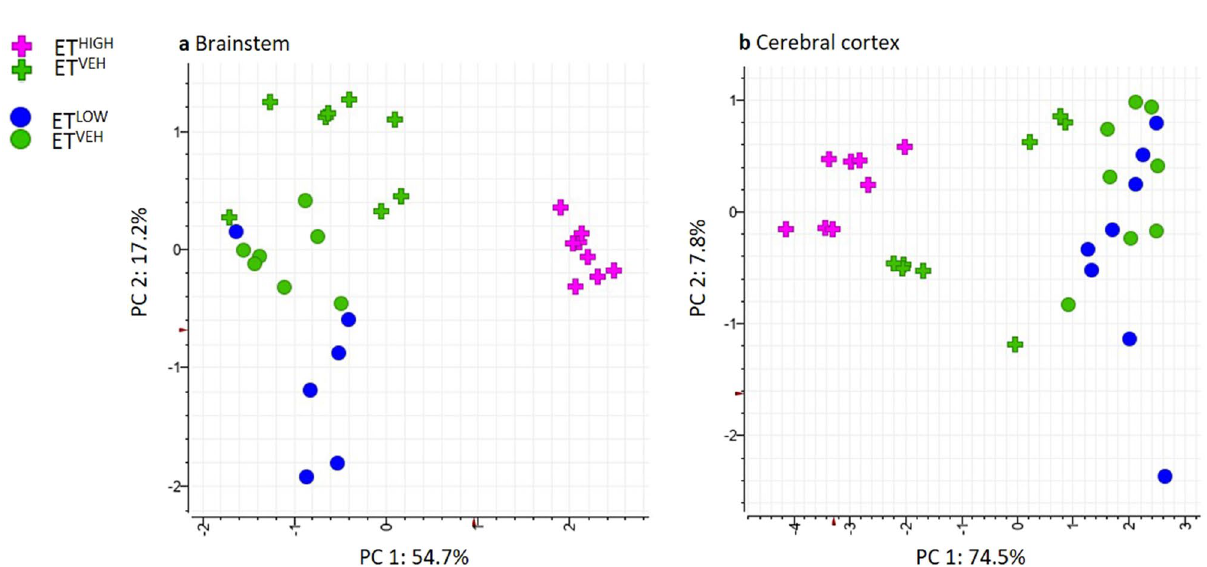
Figure 3. PCA scores plot of significant features generated from N-Way ANOVA of ( a ) brainstem (Q < 0.05) acquired from ESI+ UHPLC-HRMS of aqueous tissue extracts, representing classes ET HIGH (pink; n = 8), ET LOW (blue; n = 6) and ET VEH (green; n = 8) and ( b ) cerebral cortex (Q < 0.01) acquired from ESI+ UHPLC-HRMS of aqueous tissue extracts, representing classes ET HIGH (pink; n = 8), ET LOW (blue; n = 8) and ET VEH (green; n =